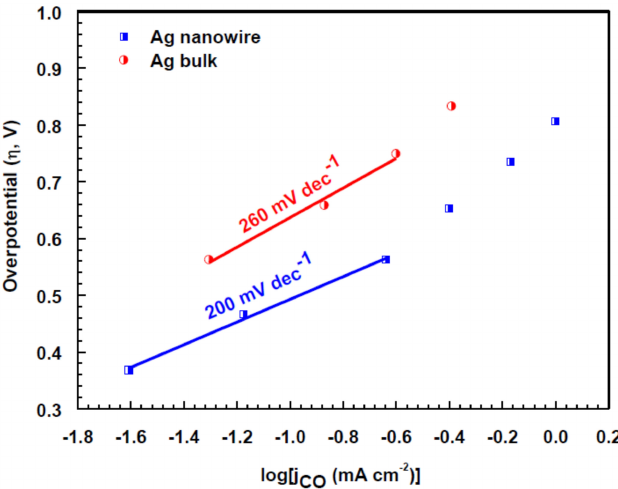
Figure 9. Tafel plots of Ag NWs/C and Ag bulk catalysts.